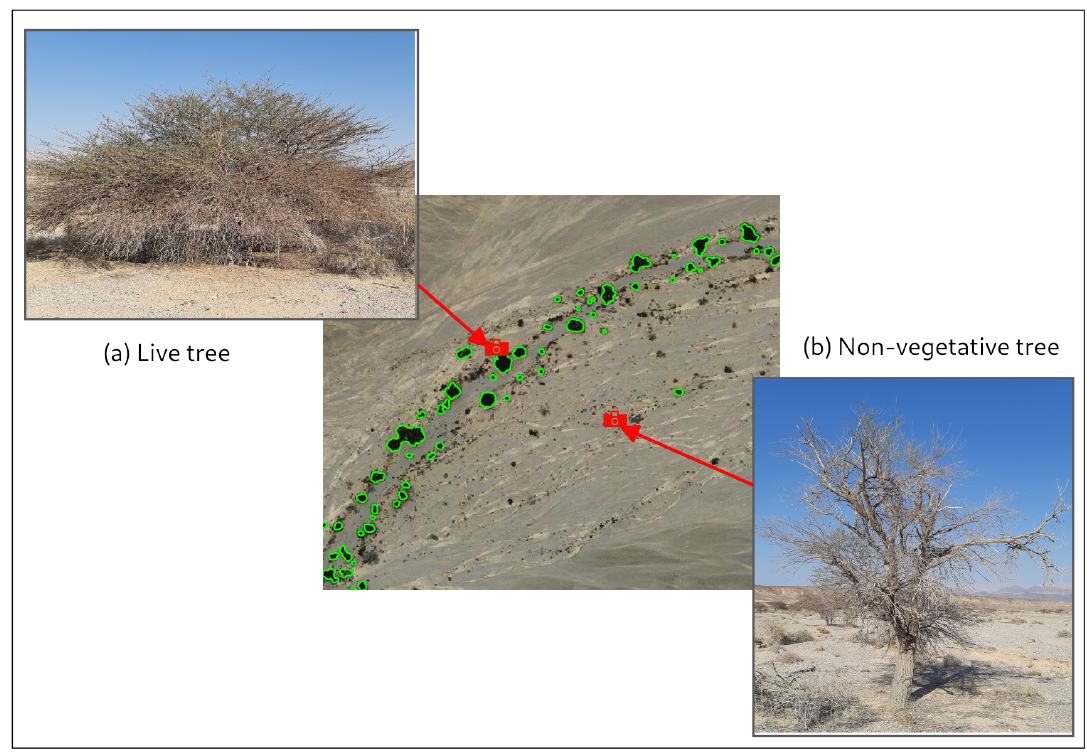
Figure 7. Closeup of the Shitta region. Two trees were photographed and the pictures georeferenced.